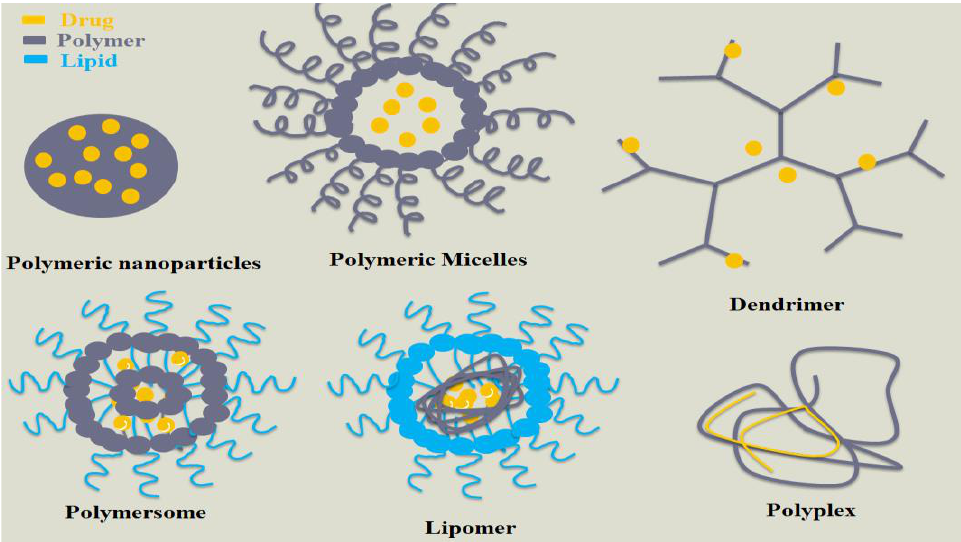
Figure 1. Different polymeric-based nanocarrier systems.